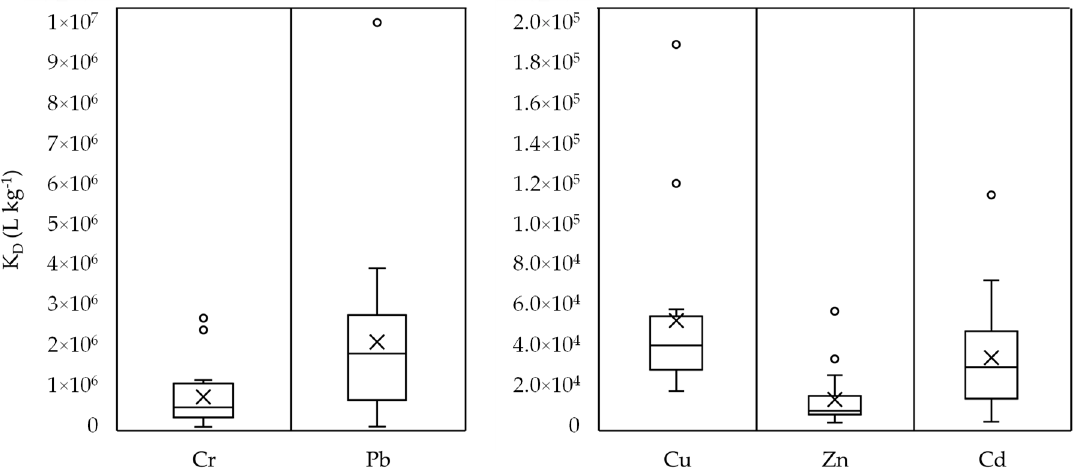
Figure 8. Equilibrium partitioning coefficient K d (L kg − 1 ) on event basis (n = 17). On the left for the metals chromium (Cr) and Lead (Pb). On the right for the metals copper (Cu), zinc (Zn), and cadmium (Cd).